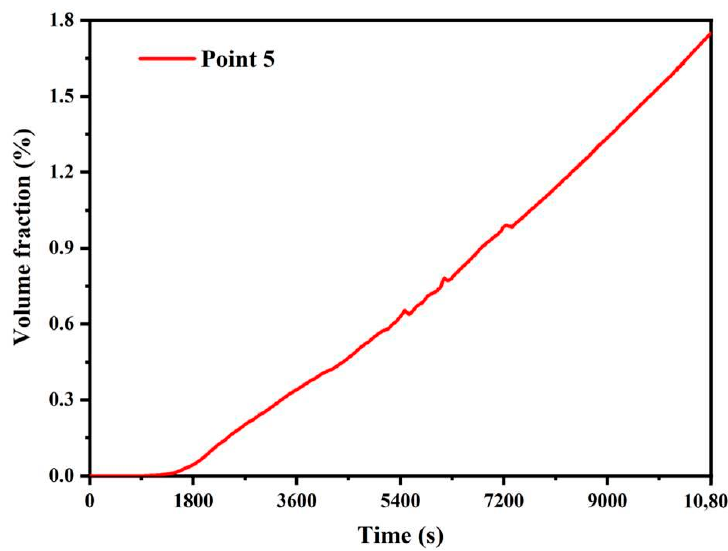
Figure 11. Gas concentration change curve at monitoring point 5.